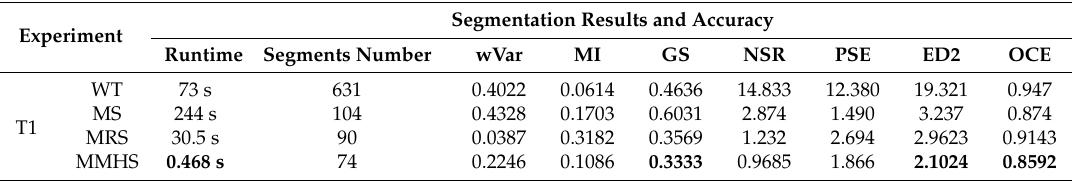
Table 5. Quantitative assessment results of the Albany QuickBird image